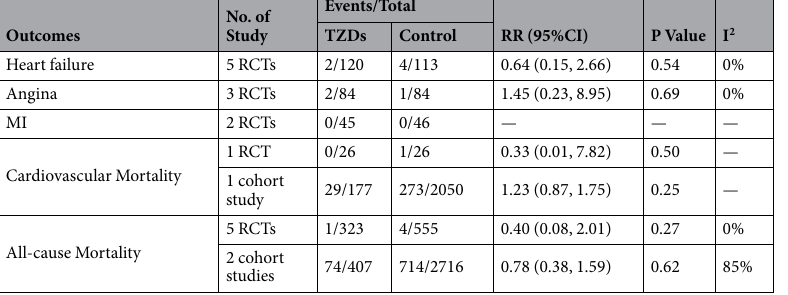
Table 2. Risk of cardiovascular events and mortality in patients with diabetes mellitus and renal impairment for the TZDs versus control